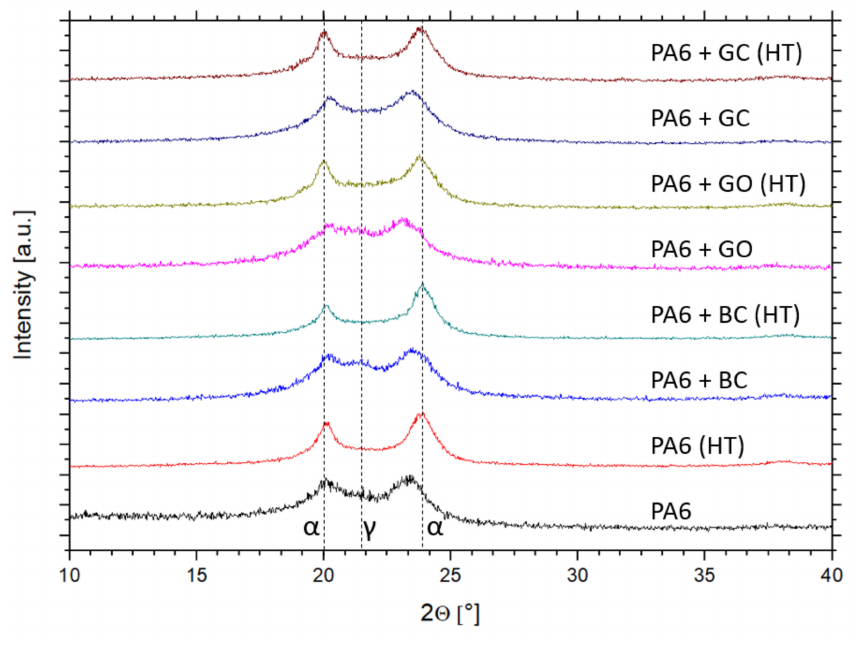
Figure 7. X-ray di ff raction patterns for obtained samples.